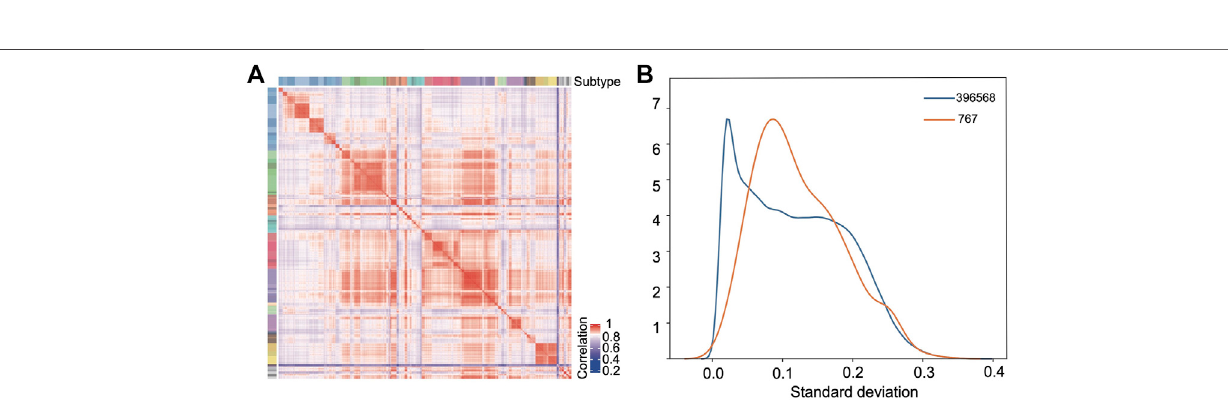
Frontiers in Bioinformatics |